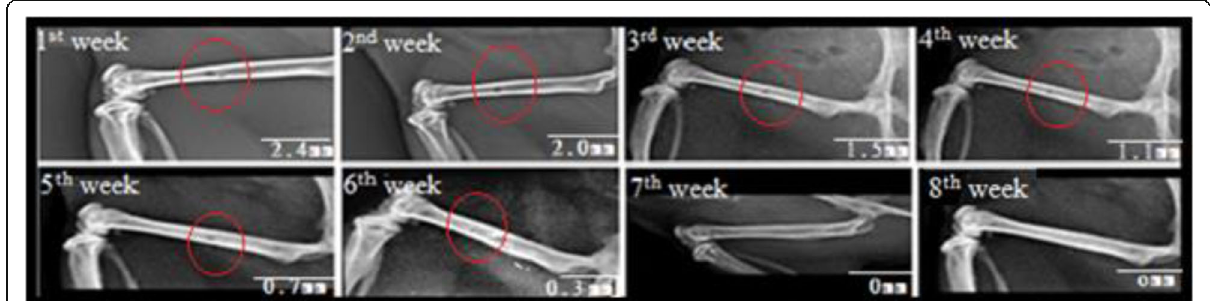
Fig. 3 Different images of a fractured bone in the standard group during the period of 8